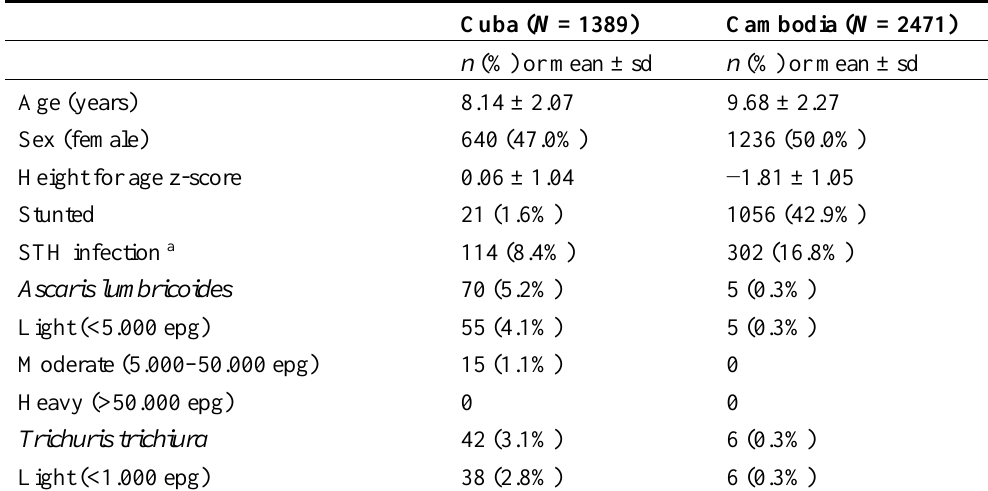
Table 1. Characteristics of the study